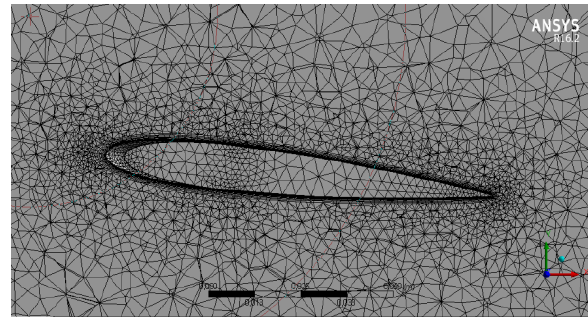
Fig. 2. The mesh structure of the wing.